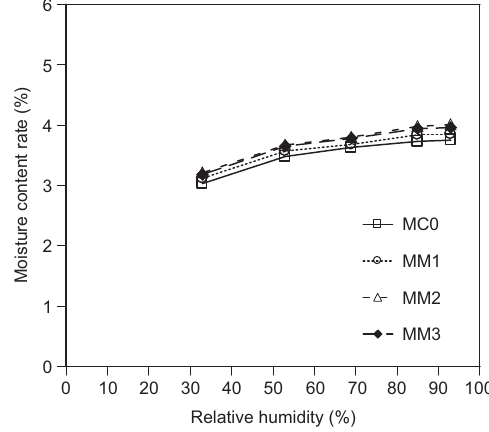
Figure 8 Desorption isotherms of cement pastes within various RHs vs. the montmorillonite contents.